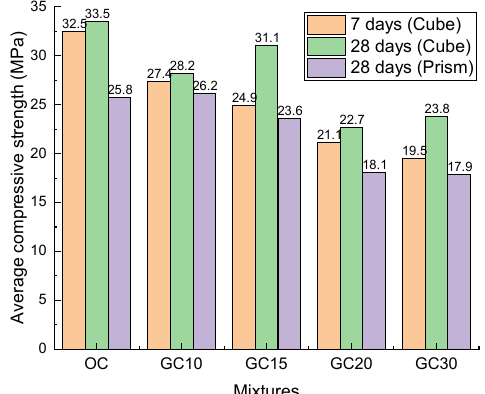
Figure 8. Compressive strength of different mixtures.